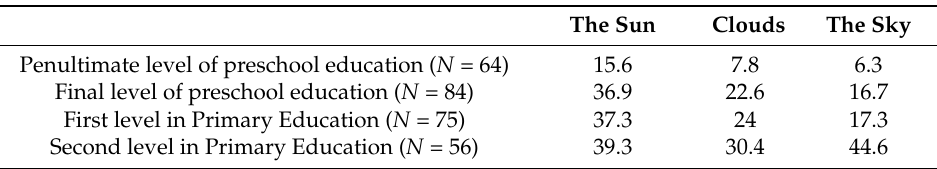
Table 2. Relative frequency (%) of the depiction of the in-sky pictorial elements within each of the educational levels under study.